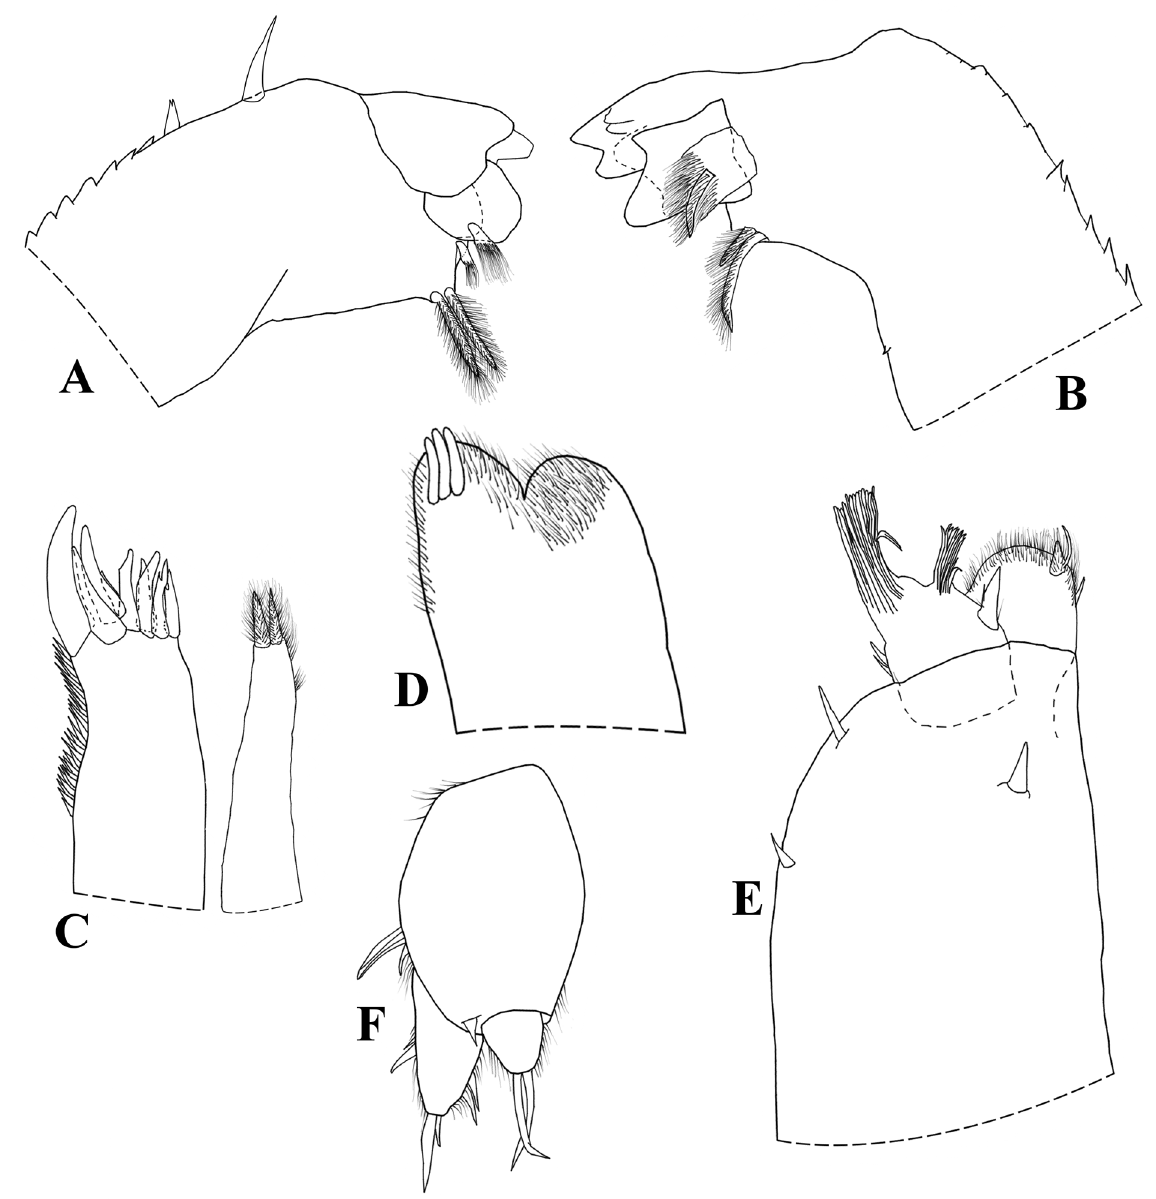
Fig. 7. Stenoniscus nestori López-Orozco, Taiti & Campos-Filho sp. nov., paratype, ♀ (CDUC- CRU 186). A . Left mandible. B . Right mandible. C . Maxillula. D . Maxilla. E . Maxilliped. F .